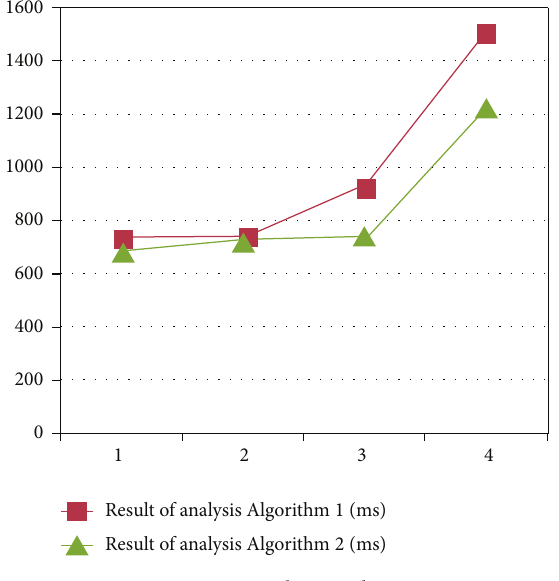
Figure 3: Database